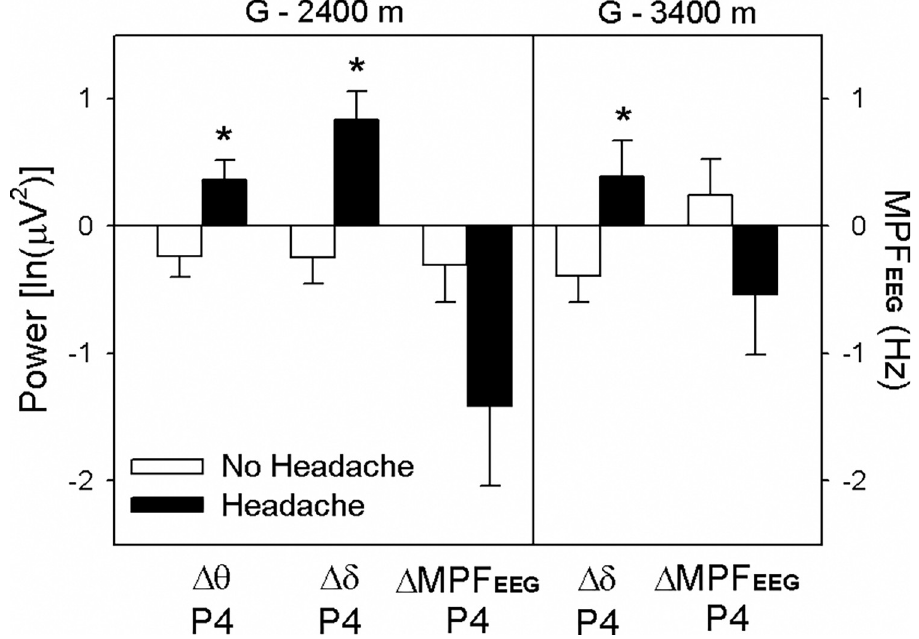
Fig 3. Comparison of the difference in θ , δ power spectral activity and mean power frequency of electroencephalography at the P4 electrode from ground to 2,400 m and to 3,400 m between two groups without and with the headache symptom. The results are presented as estimated marginal means ± standard errors (SE). � p < 0.05, compared with the non-headache group. Without headache group (n = 17); with headache group (n = 8). MPF EEG, mean power frequency of electroencephalography; P4, parietal electrode 4.